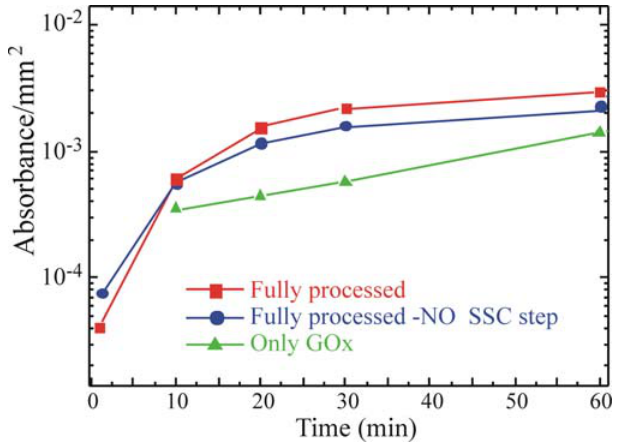
Figure 5. Glucose oxidase activity as a function of time for: bulk SiO 2 samples Fully processed (red squares), fully processed without SSC (blue circles, -NO SSC step), with only GOx (green